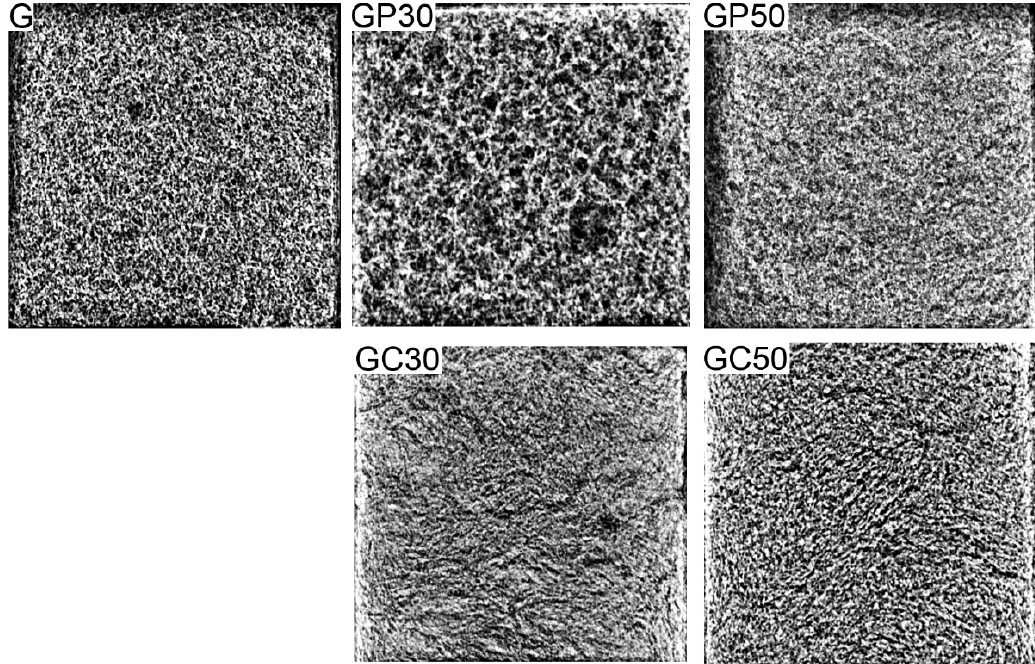
Figure 1. The radiographs of foamed geopolymer and composite materials with different